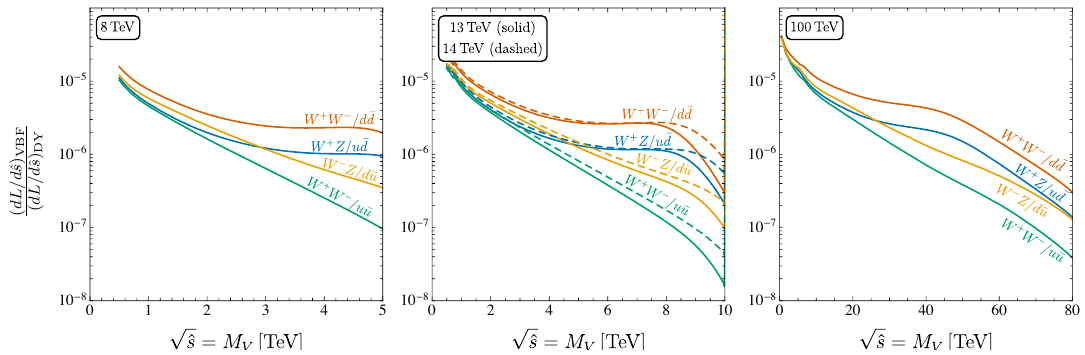
Figure 1 . The ratio of VBF to DY parton luminosities as a function of the resonance mass for different collider energies. The W + W − , d ¯ d and u ¯ u channels are relevant for V 0 production while ¯ W + Z and u d ( W − Z and d ¯ u ) are relevant for V + ( V − )